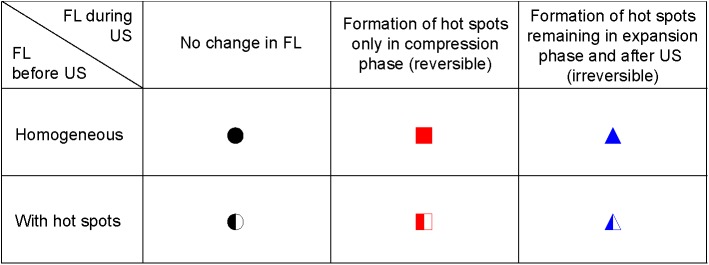
Categories of fluorescence observations during insonification.The symbols in the Fig are also used as Fig legend for Figs 4–11; see Fig 2B. FL = fluorescence; US = ultrasound.